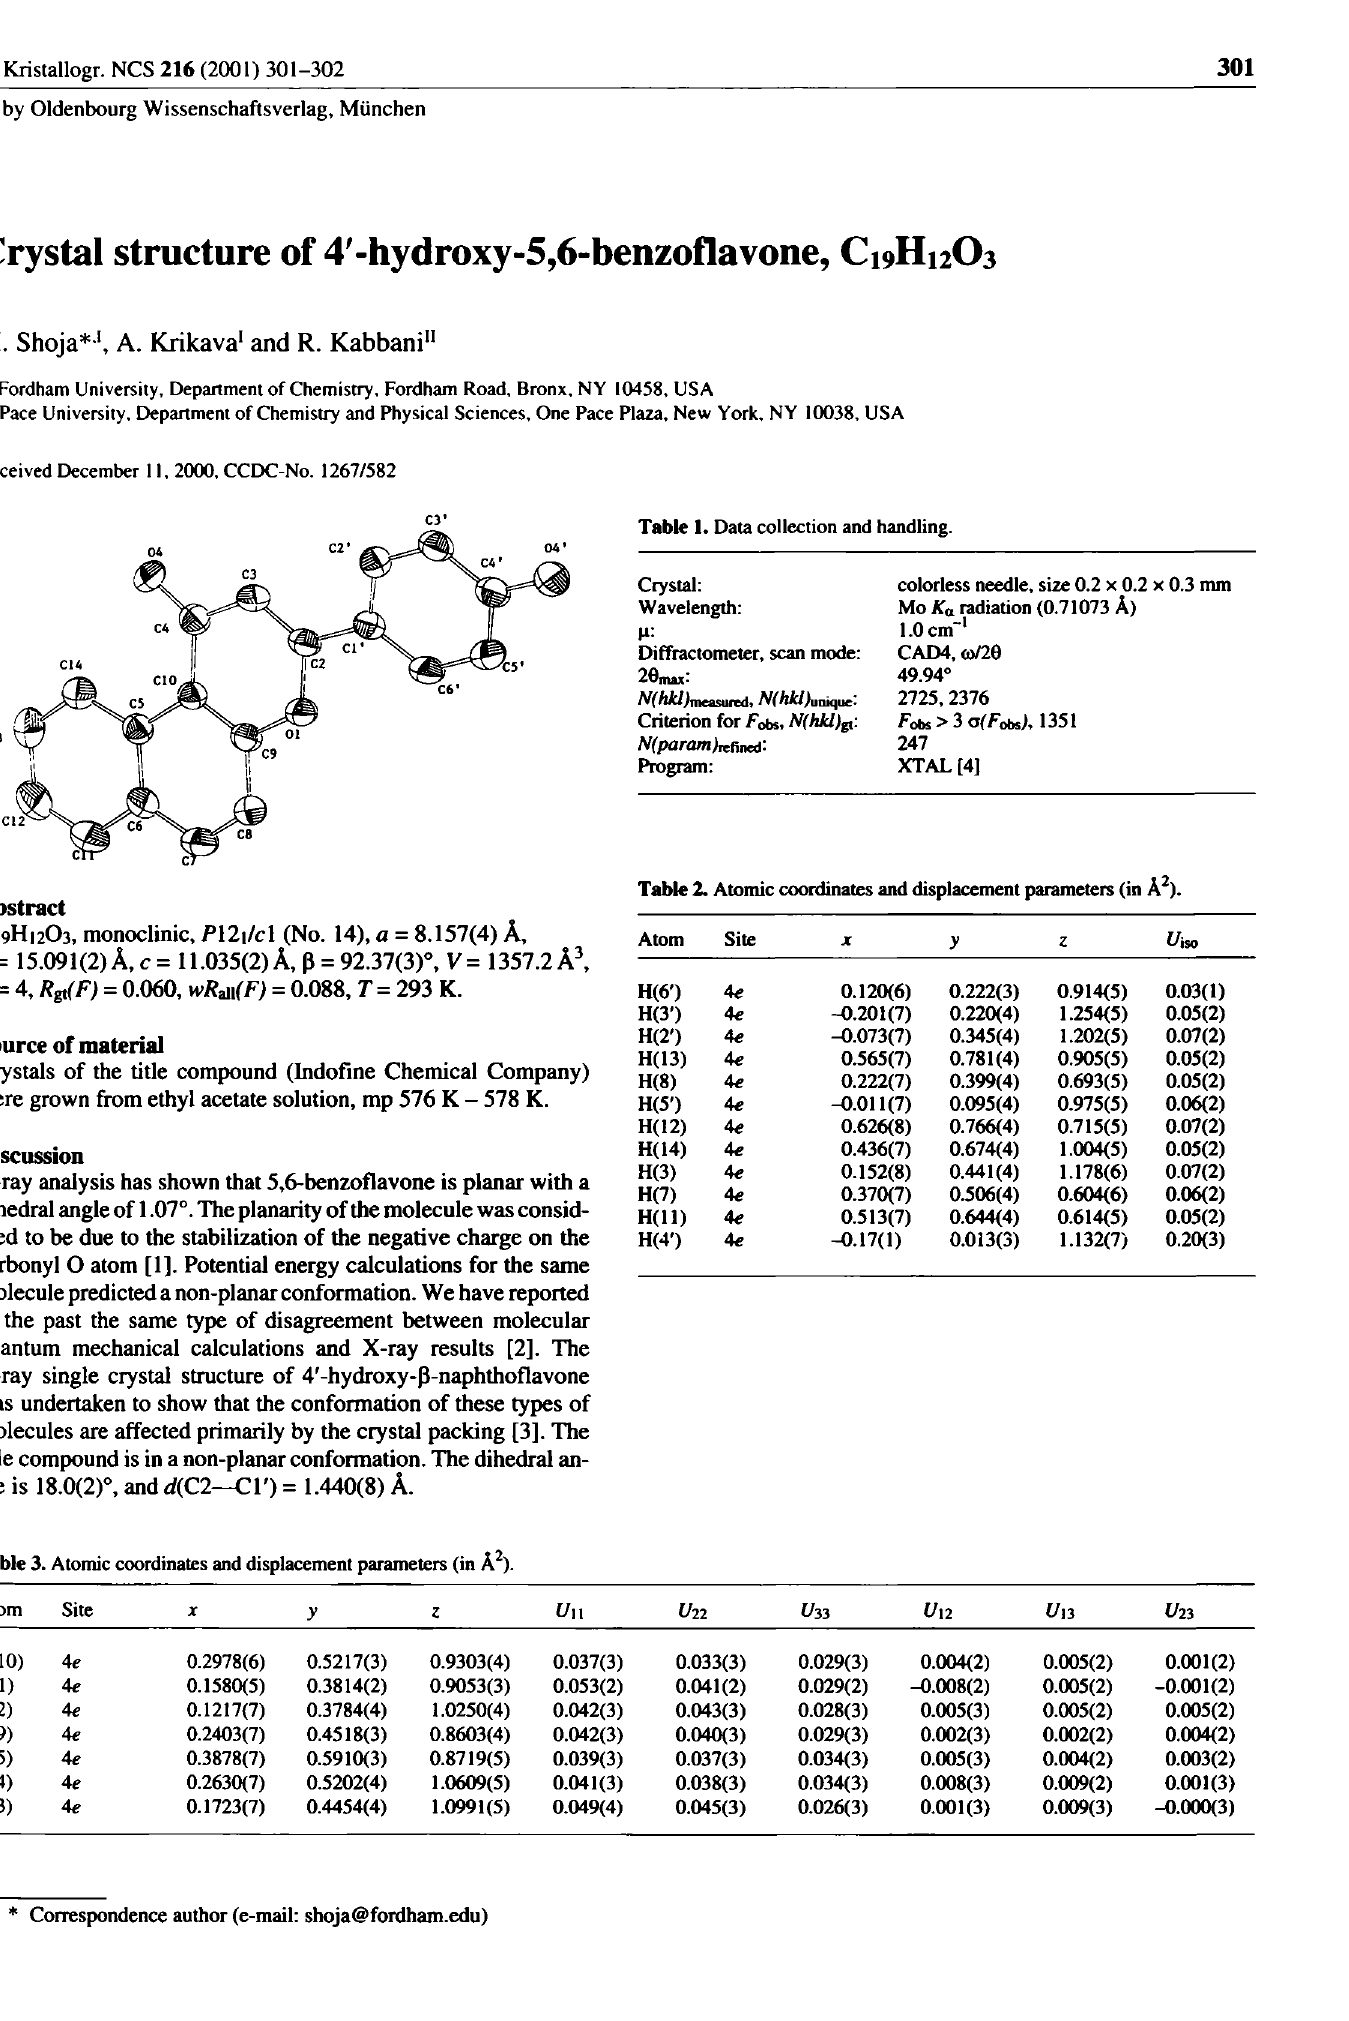
Table 1. Data collection and handling.